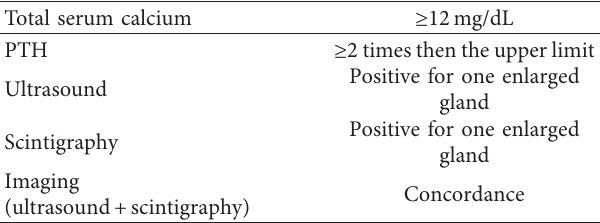
Table 1: CaPTHUS